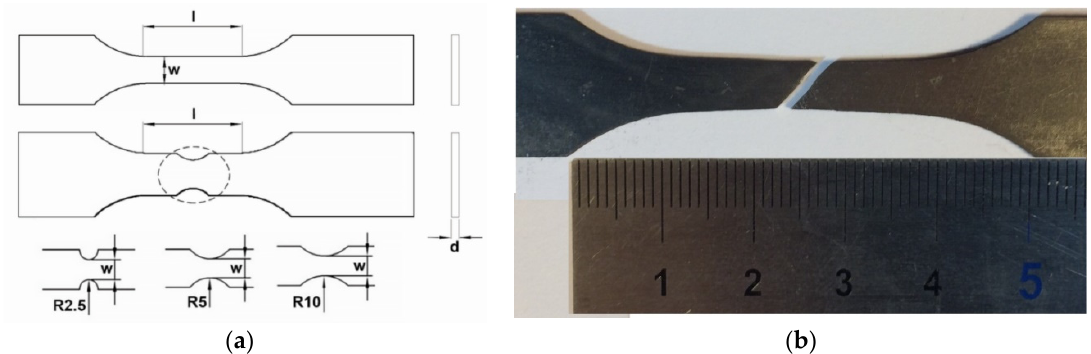
Figure 1. Schematic of notched specimen. ( a ) Initial geometry of specimen and ( b ) photo of the fractured sample.